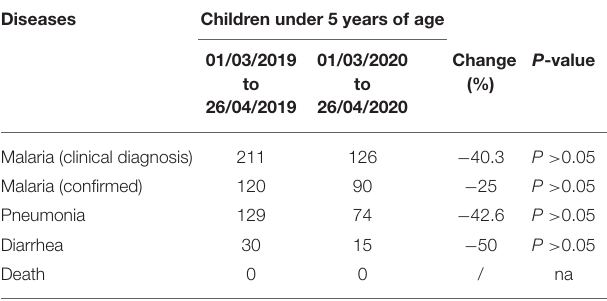
TABLE 1 | Vaccination performed in a community health center in Sierra Leone during COVID-19 lockdown, compared with the previous year. Vaccination